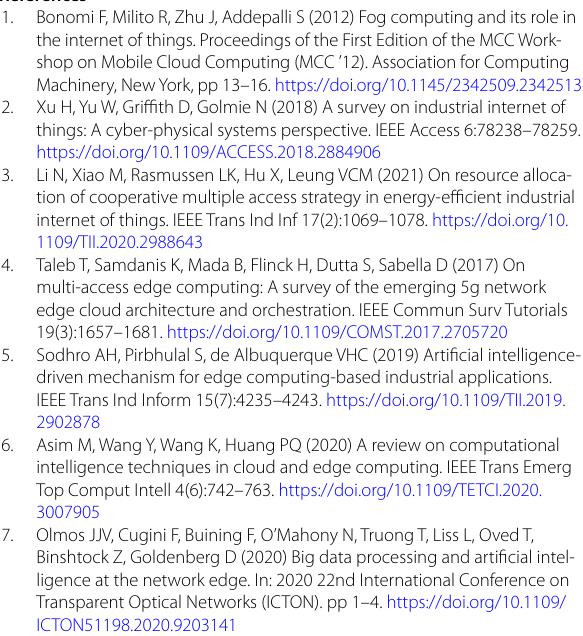
Fig. 8 The workload acceptance ratio compared to FogNetSim number of user nodes is increased, and the proposed framework keep accepting the